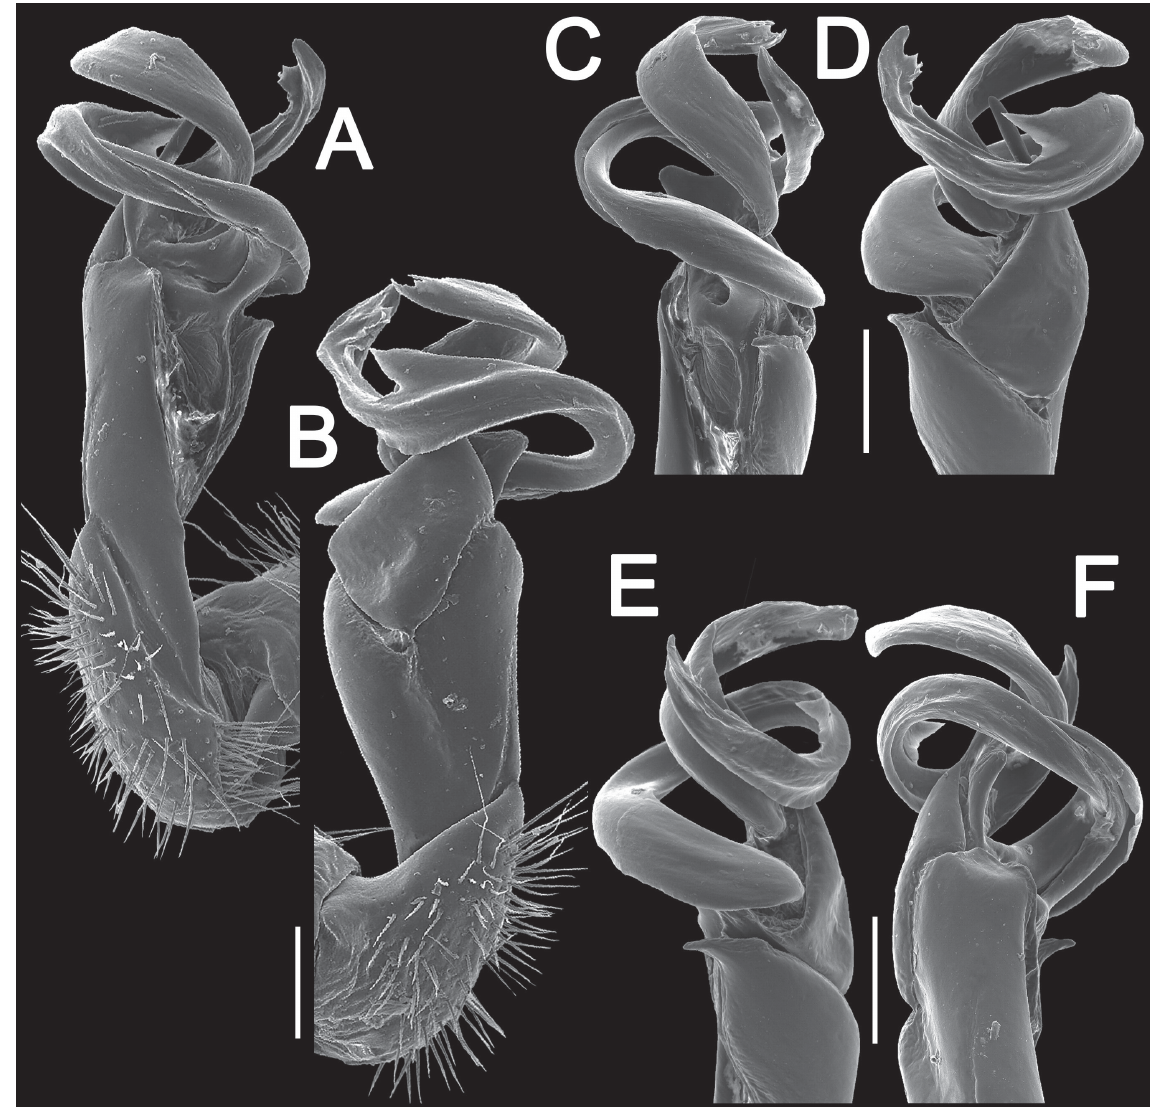
Fig. 20. Tylopus thunghaihin sp. nov., holotype, ♂, right gonopod. A–B . Mesal and lateral views, respectively. C–F . Distal part, submesal, sublateral, subcaudal and suboral views, respectively. Scale bars = 0.2